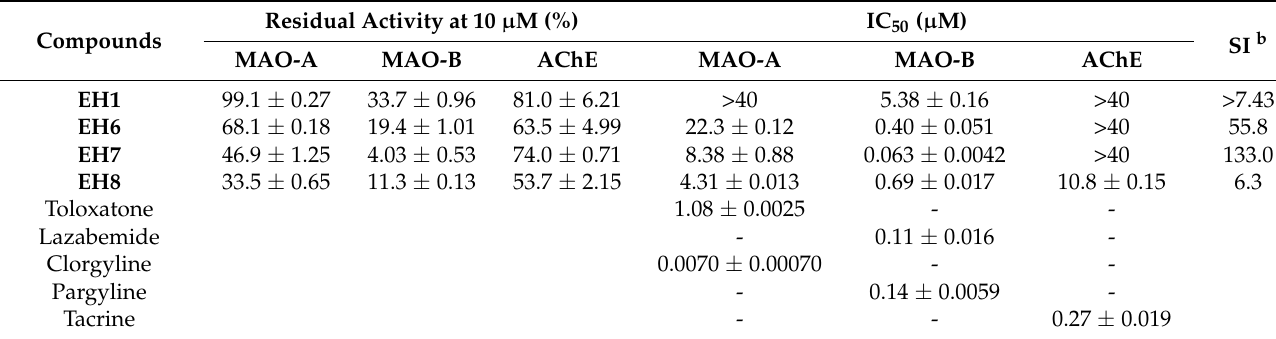
Table 1. Inhibitions of recombinant human MAO enzymes by compounds of the EH series a